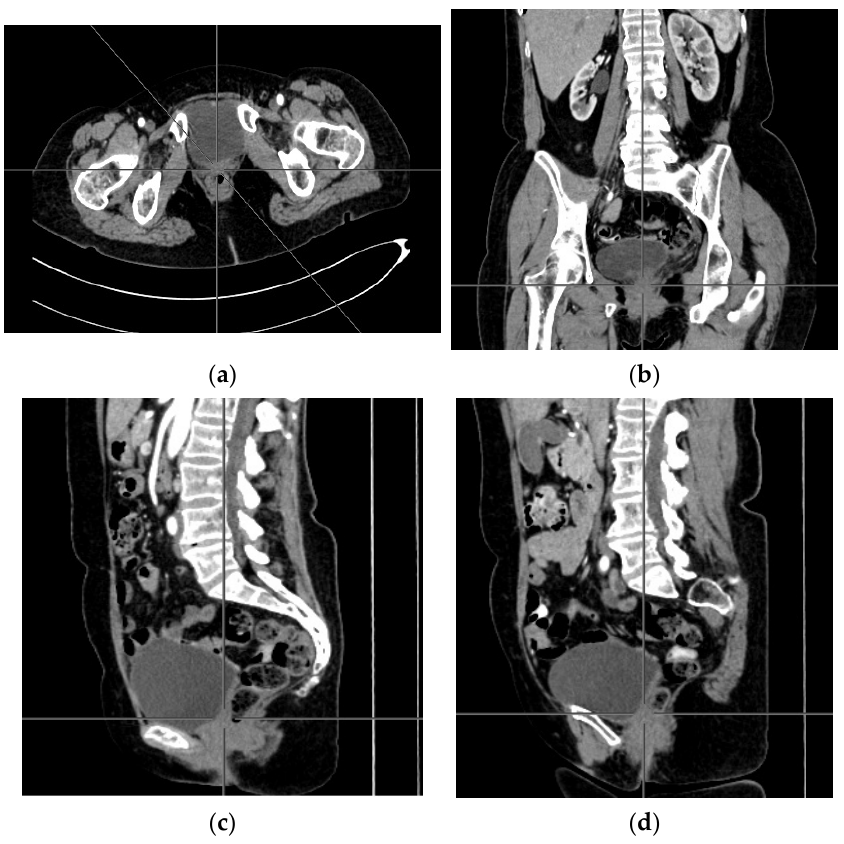
Figure 3. ( a – d ) CT scans performed before 48 cycle of olaparib treatment .